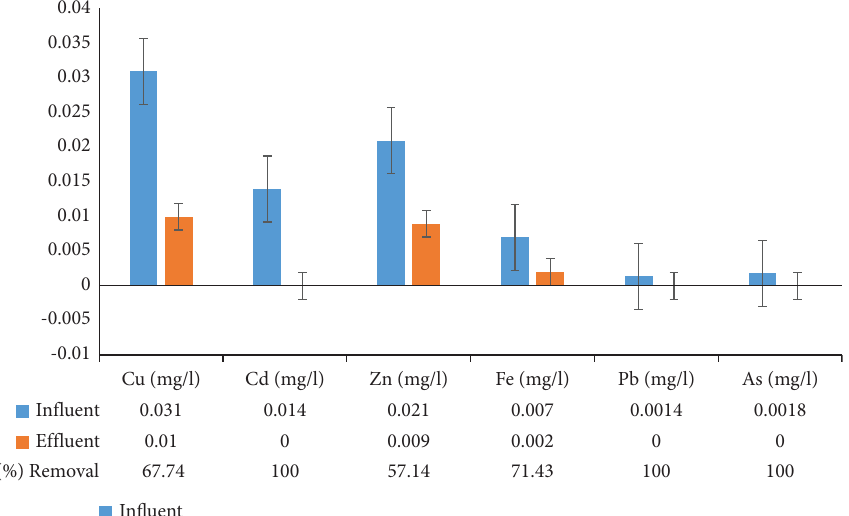
Figure 7: Output of infuent-efuent values showing signifcant diference for some of the heavy metals